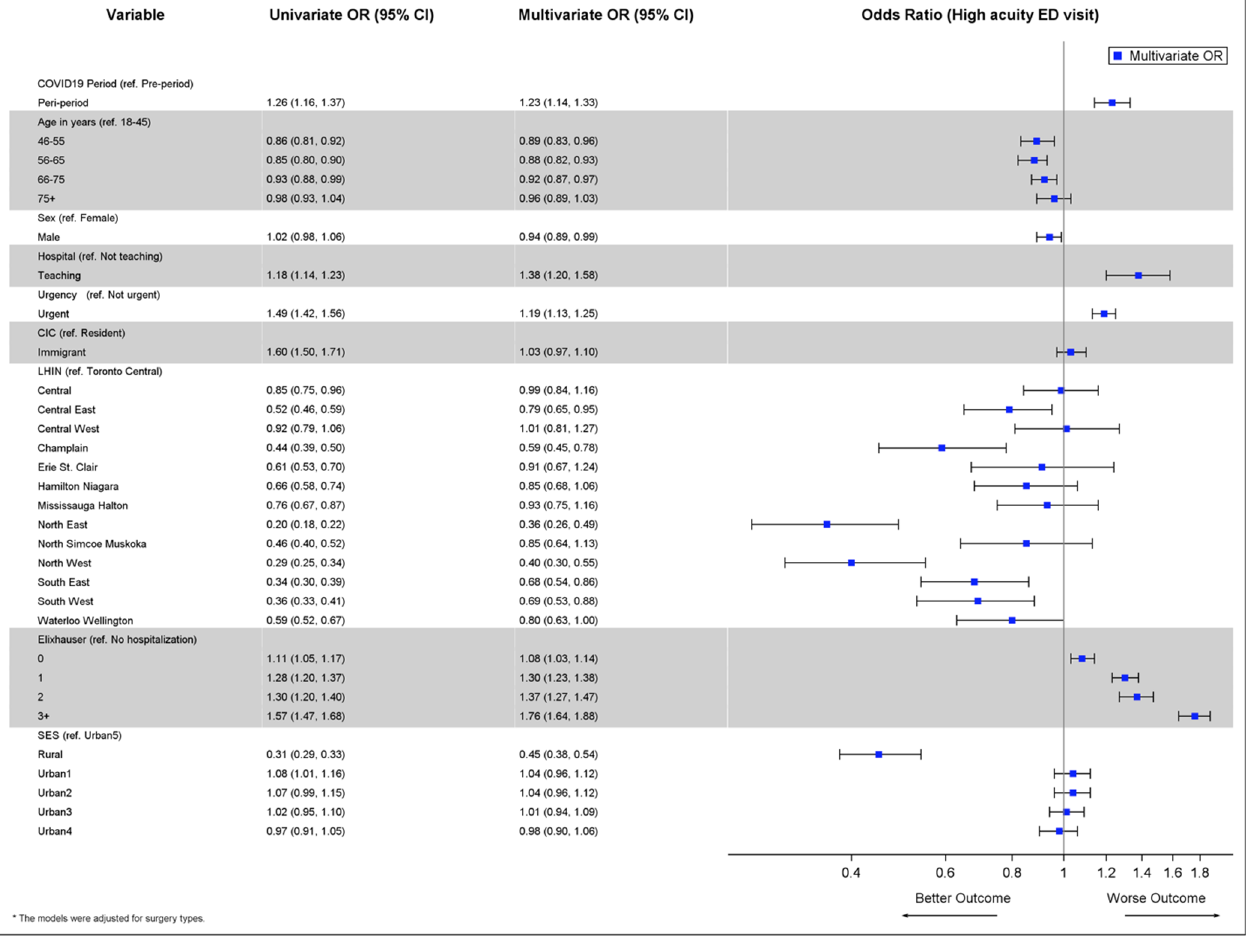
Figure 4. Forest plot illustrating the associations between characteristics and the odds of the ED visit being of high acuity (among cohort of cancer-directed surgeries that resulted in an ED visit within 30 days post discharge).